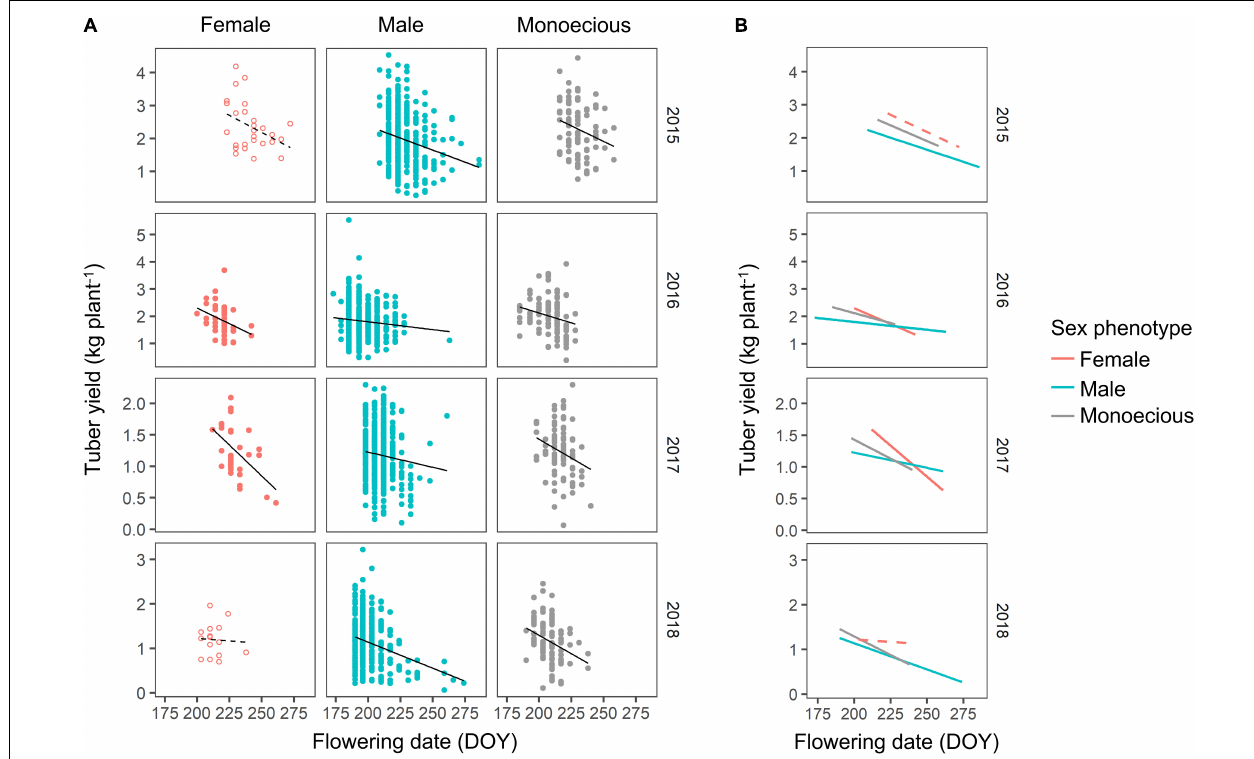
FIGURE 6 | Correlation between flowering date and tuber yield. (A) The relationship is separately shown with a regression line for each of the sex phenotypes and years. The open circles with dashed regression line indicate that the correlation was not statistically significant at P < 0.05. The correlation coefficient and significance are the same as indicated in Figure 5 . (B) The regression line of different sex phenotypes is